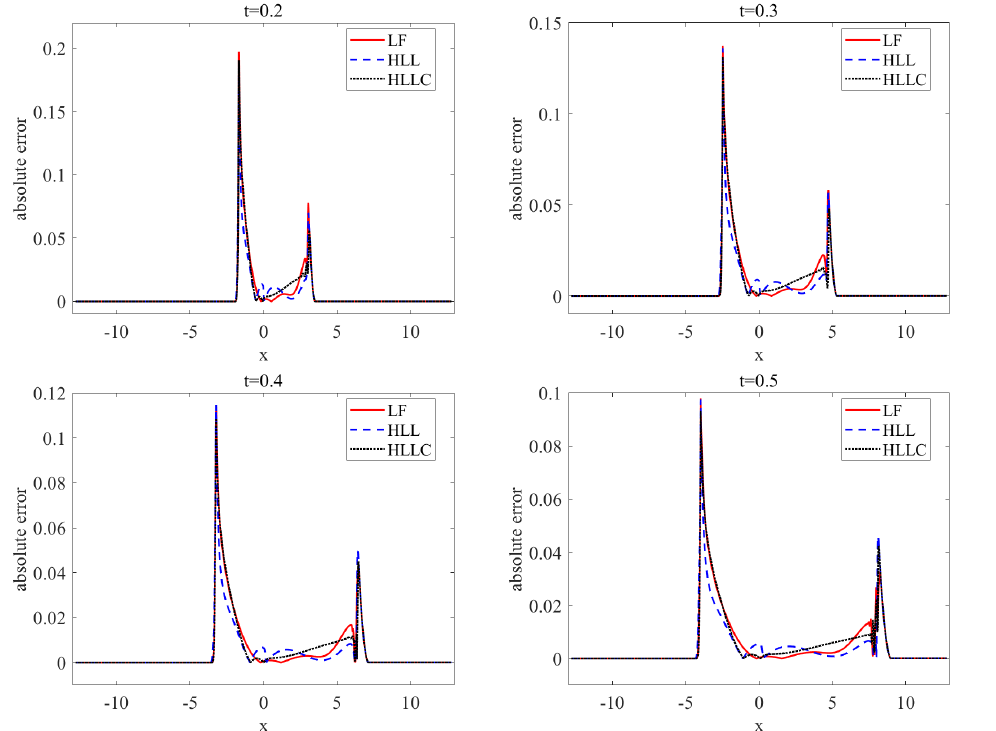
Figure 5. The depth’s pointwise absolute error of numerical solutions with WENO–LF, WENO–HLL, and WENO–HLLC fluxes for the 1D dam break problem at t = 0.2,0.3,0.4 and